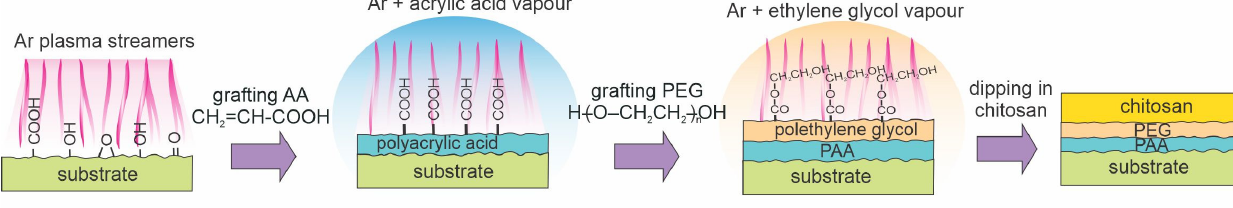
Figure 14. A method for immobilizing chitosan using two different intermediate layers, both prepared by plasma polymerization at atmospheric pressure, using Ar with an admixture of acrylic acid or ethylene glycol vapors.